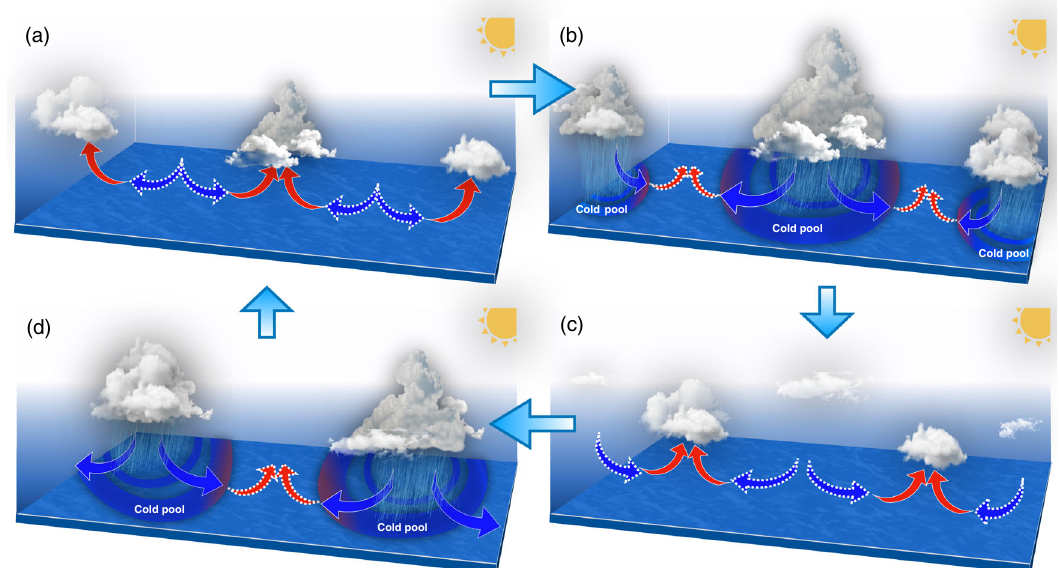
Fig. 6 Schematic description of the mechanism behind oscillating deep-open-cells. a Cloud walls form at open cell ’ s boundaries. b Rain starts in deeper wall clouds and causes cold pools. c New clouds develop by the cold pool fl ow and form cloud walls for the new generated open cells. d New rain events by the mature wall clouds trigger a new oscillation